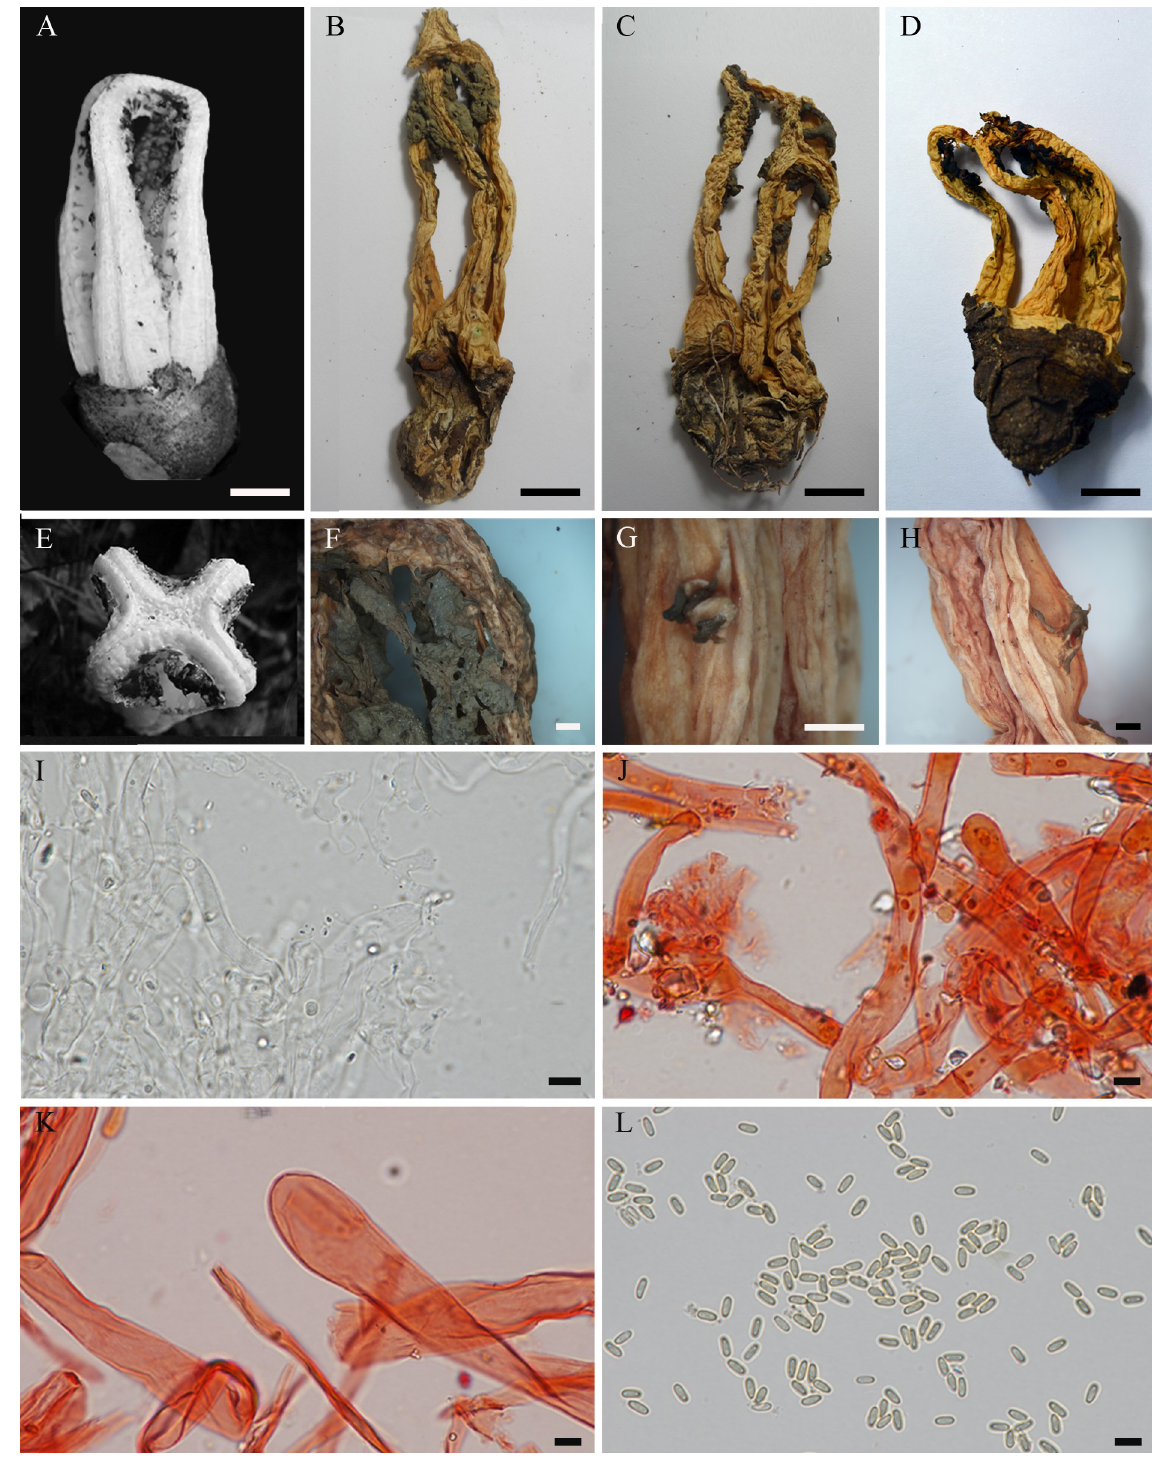
Fig 10. Blumenavia toribiotalpaensis . (A) Fresh basidiomata, black and white image reproduced Vargas-Rodriguez and Va´zquez-Garcı´a [7] Fig 3, © Vargas-Rodriguez and Va´zquez-Garcı´a. (B, C) Dry basidiomata, BPI 870955, holotype. (D) Dry basidiomata, IBUG 456, paratype. (E) Top view of fresh basidiomata show groove in the arm, black and white image reproduced from Va´zquez-Garcı´a [7] Fig 5, © Vargas-Rodriguez and Va´zquez-Garcı´a. (F) Lacerated projections of glebifer, BPI 870955, holotype. (G, H) Torn and twisted points of glebifer, BPI 870955, holotype. (I, J) IBUG 454, paratype: (I) Apical exoperidium hyphae in 5% KOH; (J) Apical exoperidium hyphae in 1% Congo red. (K)